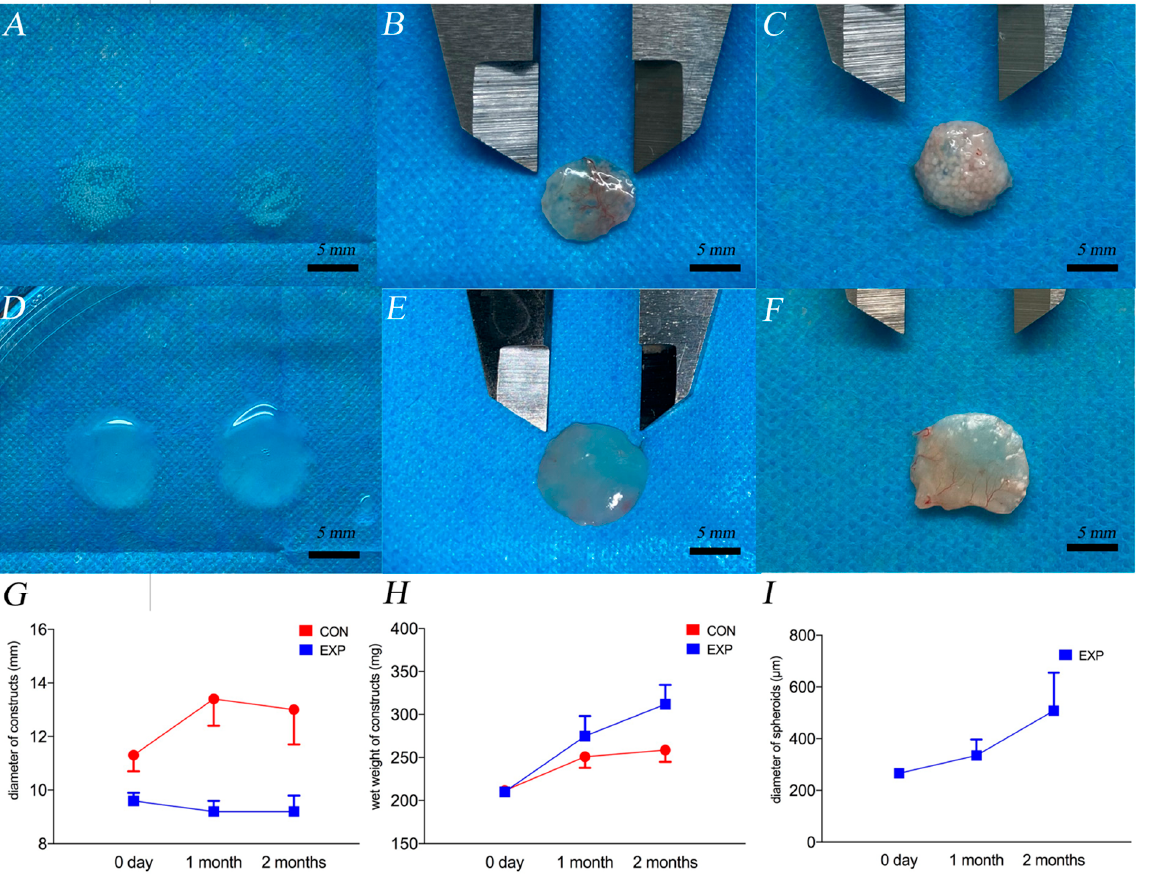
Figure 4. The gross view of constructs in the EXP group before implantation ( A ), 1 month after implantation ( B ), and 2 months after implantation ( C ). The gross view of constructs in the CON group before implantation ( D ), 1 month after implantation ( E ), and 2 months after implantation ( F ). Scar bar = 5 mm. The calcification points in the CON group at 2 months are marked as red arrows. ( G ) The changes in the diameter of constructs, ( H ) the wet weight of constructs, and ( I ) the diameter of chondro-spheroids. The blue spots and lines represent the EXP group, and the red spots and lines represent the CON group.